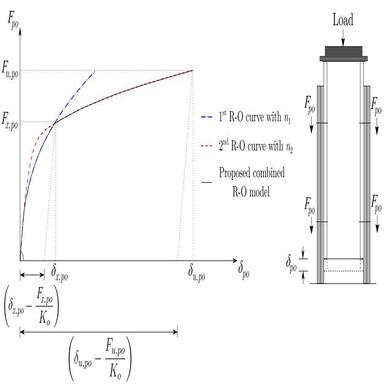
Proposed combined Ramberg–Osgood model consisting of two single Ramberg–Osgood curves for describing the shear load-slip behaviour of screw connections between cold-formed steel and sheathing.